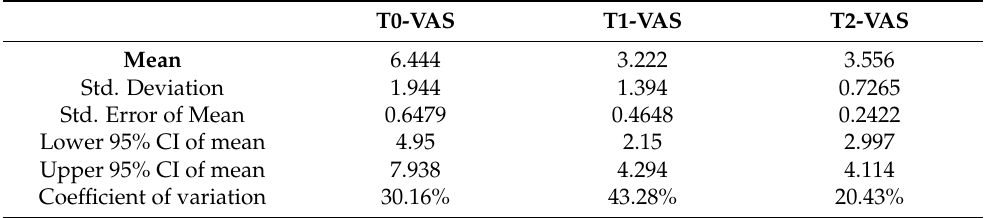
Figure 3. VAS values before treatment (T0), after treatment at 21 days (T1) and at 3-months follow- up (T2).